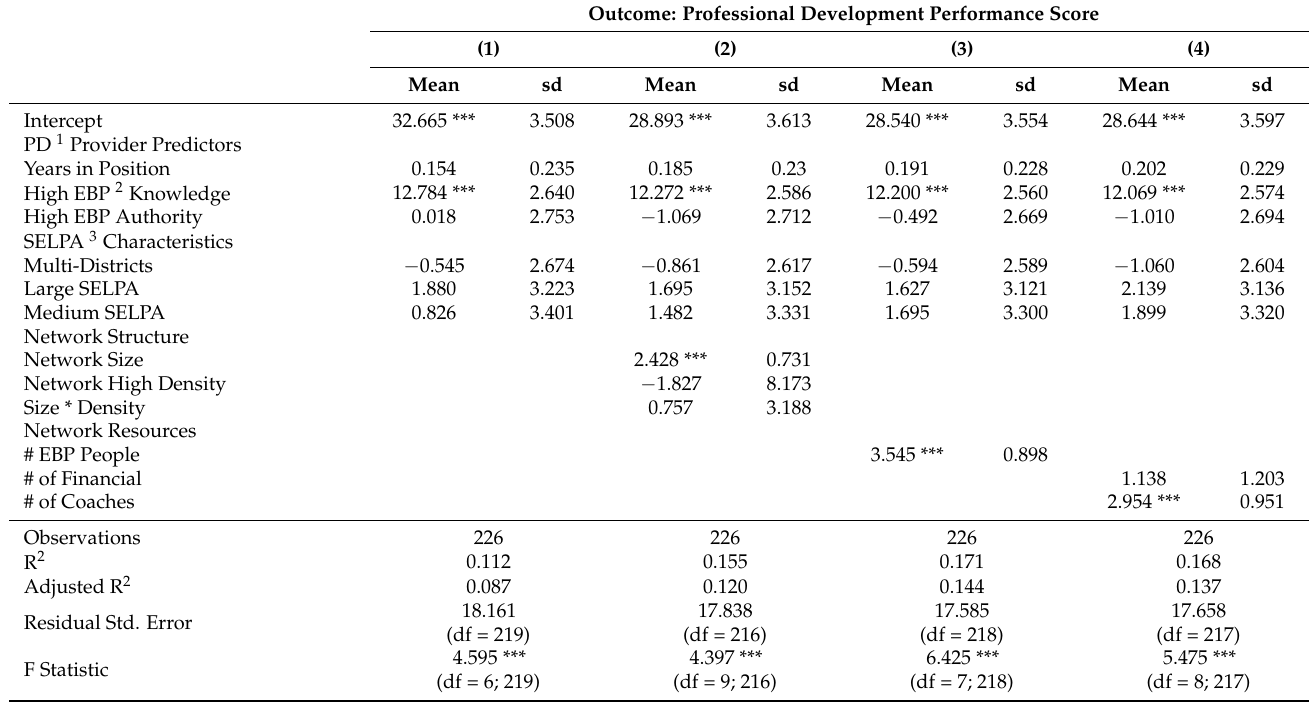
Table 3. CAPTAIN PD providers performance success